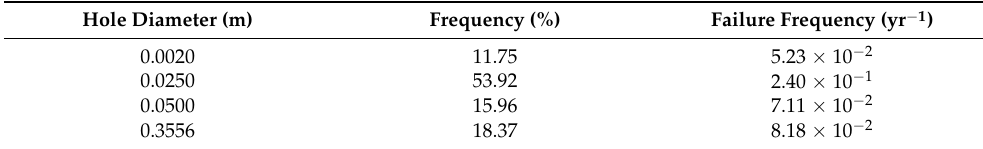
Table 3. Failure frequency (yr − 1 ) for each failure size scenario.